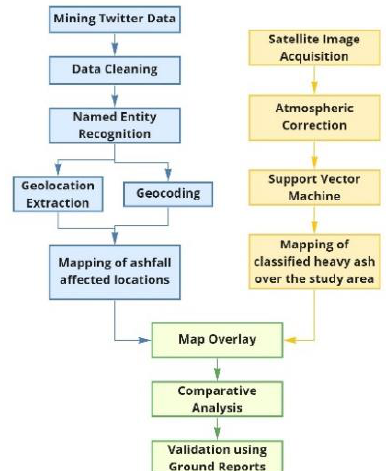
Figure 1. General workflow for social media data and satellite imagery